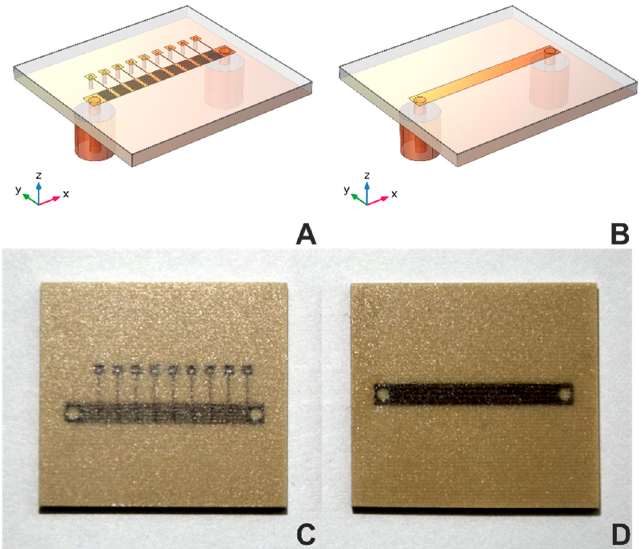
Figure 1. Geometries and photographs of sensors. Geometries of ( A ) MTM9 and ( B ) MSTL sensors. Photographs of ( C ) MTM9 and ( D ) MSTL sensor.